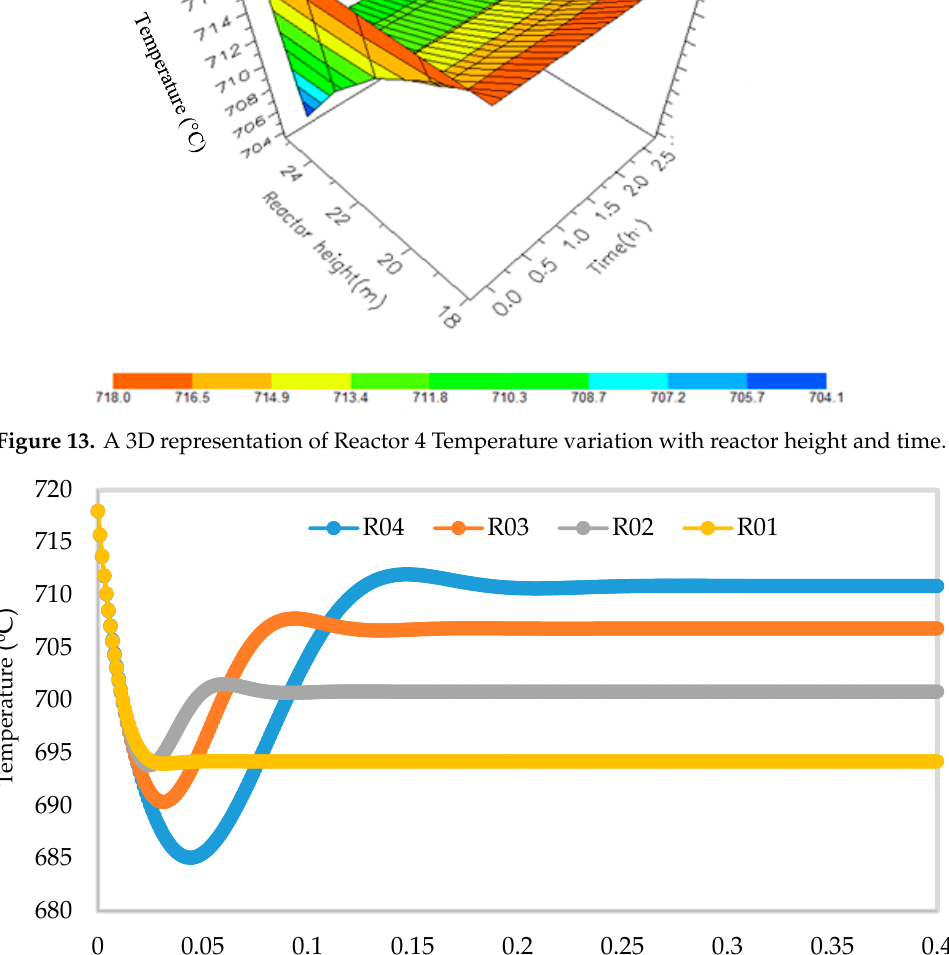
Figure 14. Dynamic behaviour of Temperature in the four reactors.